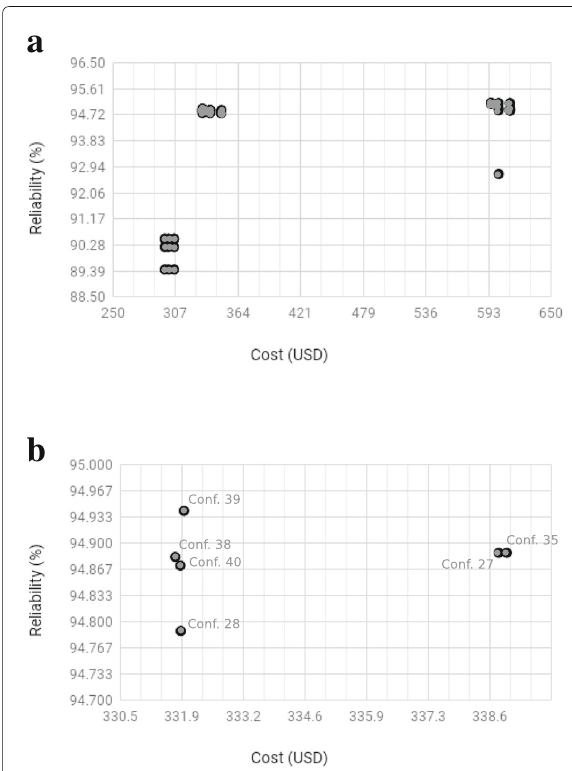
Fig. 8 Ranking of the configurations generated for the second case scenario. a Overview of all ranked configurations. b Optimal configurations